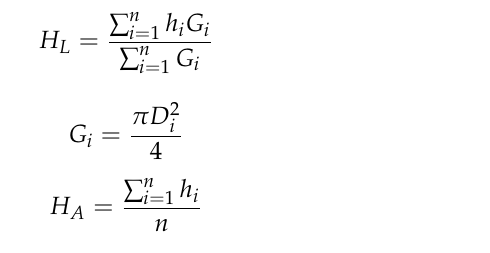
Figure 2. Histogram of tree heights of different forest cases (ALL plots ( a ), LYS plots ( b ), YS plots ( c )). The Lorey’s height ( H L ), mean height ( H A ), dominated height ( H Dom ), and median height ( H Med ) were calculated as forest stand height. H L , calculated using DBH and height, Table 1. Descriptive statistics of field plots. the two critical parameters of each tree, could better represent the stand height. H A is the average height of all individual trees with DBH ≥ 5 cm in each ground plot. H Dom is the Forest Parameters Symbol Range average height of 20% top trees [34]. H Med is the median height of each ALL plots ( n = 71)